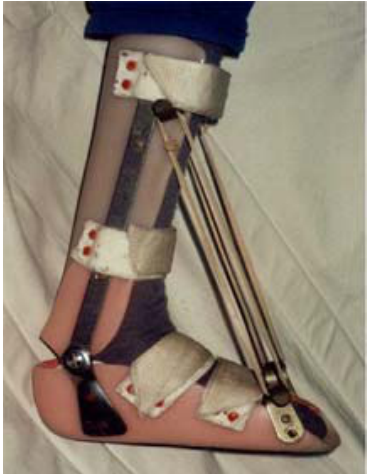
FIGURE 6. An active stretching